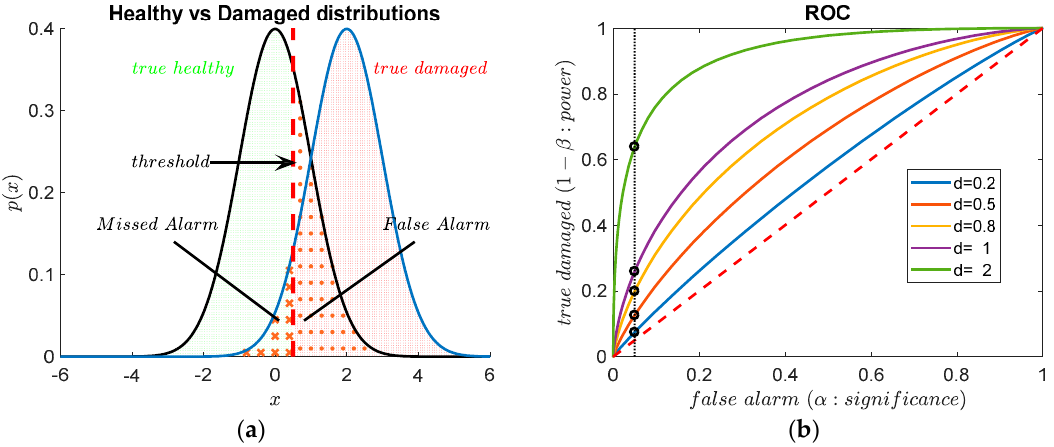
Figure 7. Receiver Operating Characteristic (ROC) as a function of the threshold (Gaussian distributions). ( a ) graphical summary of the table of type I and type II errors in yellow (Table 9). ( b ) ROC for binary classification with different effect sizes 𝑑 ∗ and the position of the 95% critical value (black dotted). For 𝑑 ∗ = 0.2 the performance is very poor as the ROC is near to the 1st–3rd quadrant bisector (random classifier).